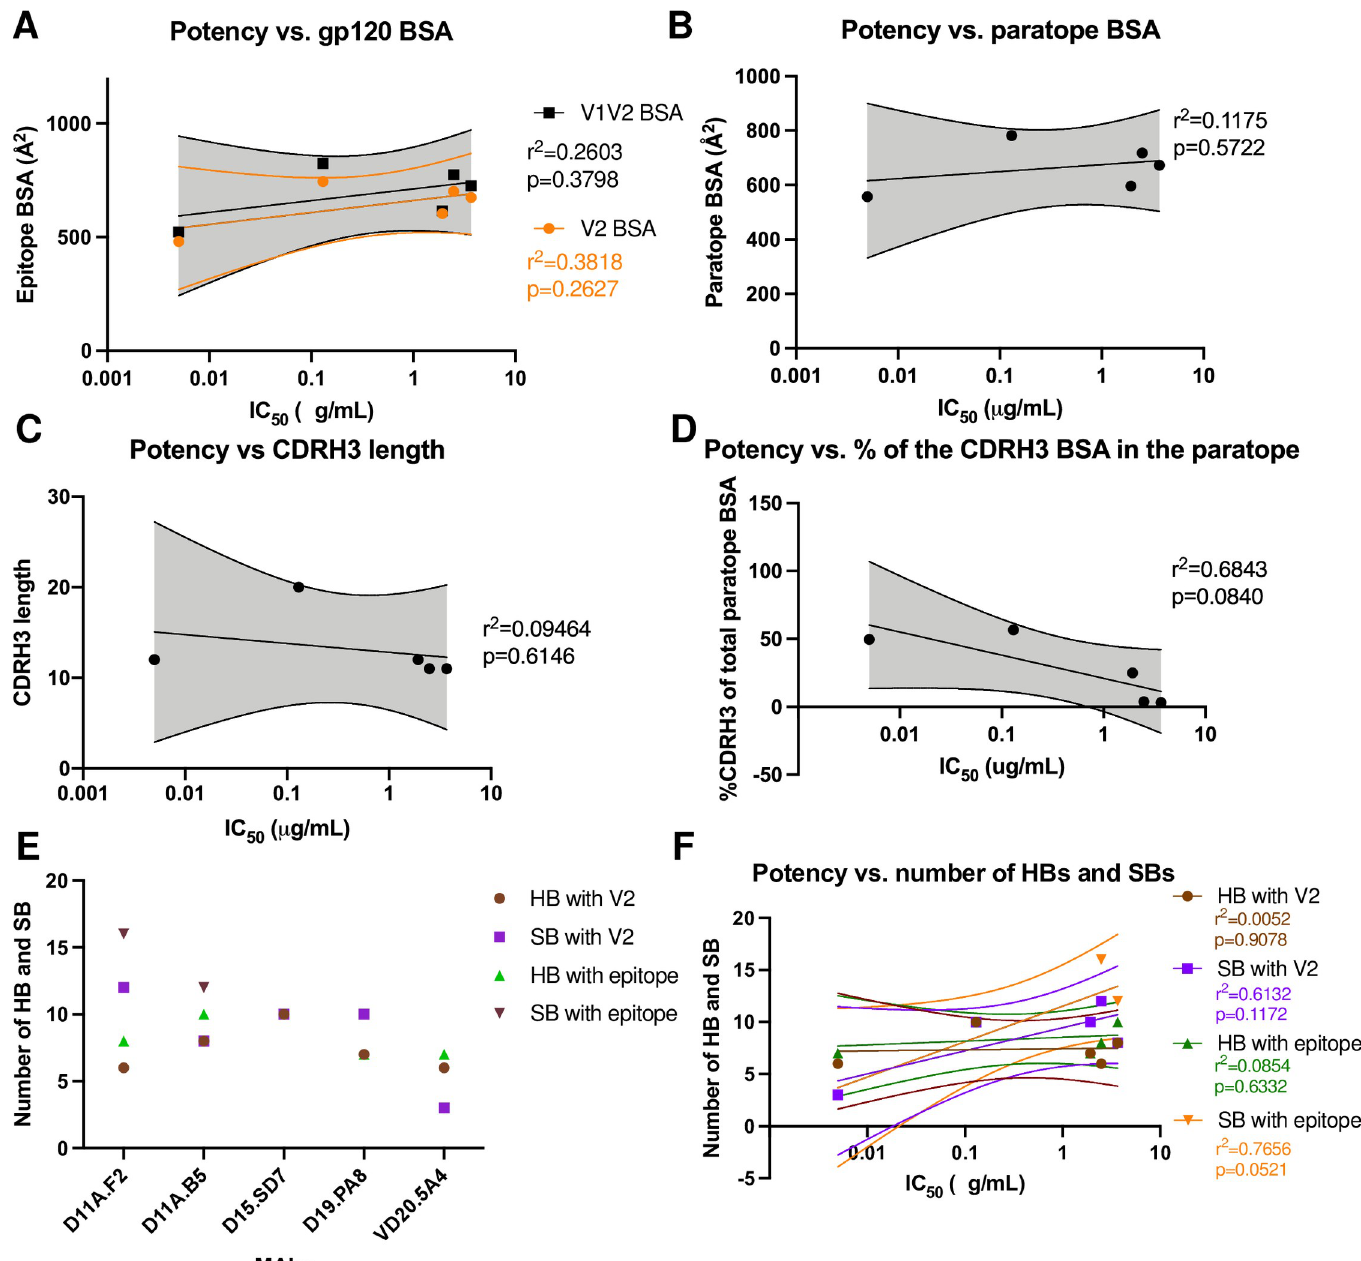
Fig 4. MAbs binding properties and correlations with autologous neutralization potency. Correlation between autologous neutralization potency and ( A ) epitope surface area, ( B ) paratope surface area, ( C ) CDRH3 length, ( D ) relative contribution of the CDRH3 surface area in the paratope and ( F ) number of Hydrogen Bonds (HBs) and Salt Bridges (SBs). The lines indicate the fitted linear regression model with 95% confidence shown in shaded grey or color as indicated. The r 2 and p values are displayed. ( E ) Graph indicates number of HBs and SBs between the epitope/paratope with the different mAbs.